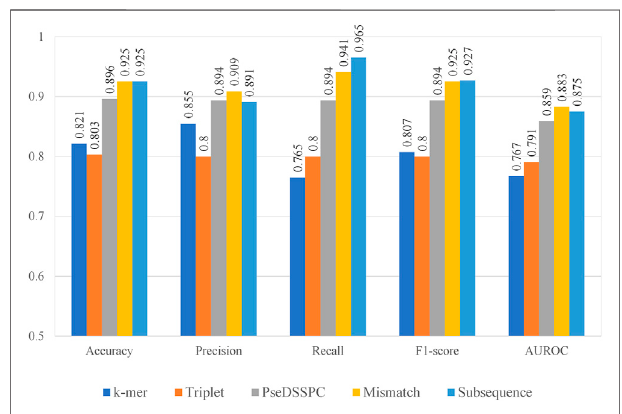
FIGURE 2 | Prediction performances using fi ve different types of features with